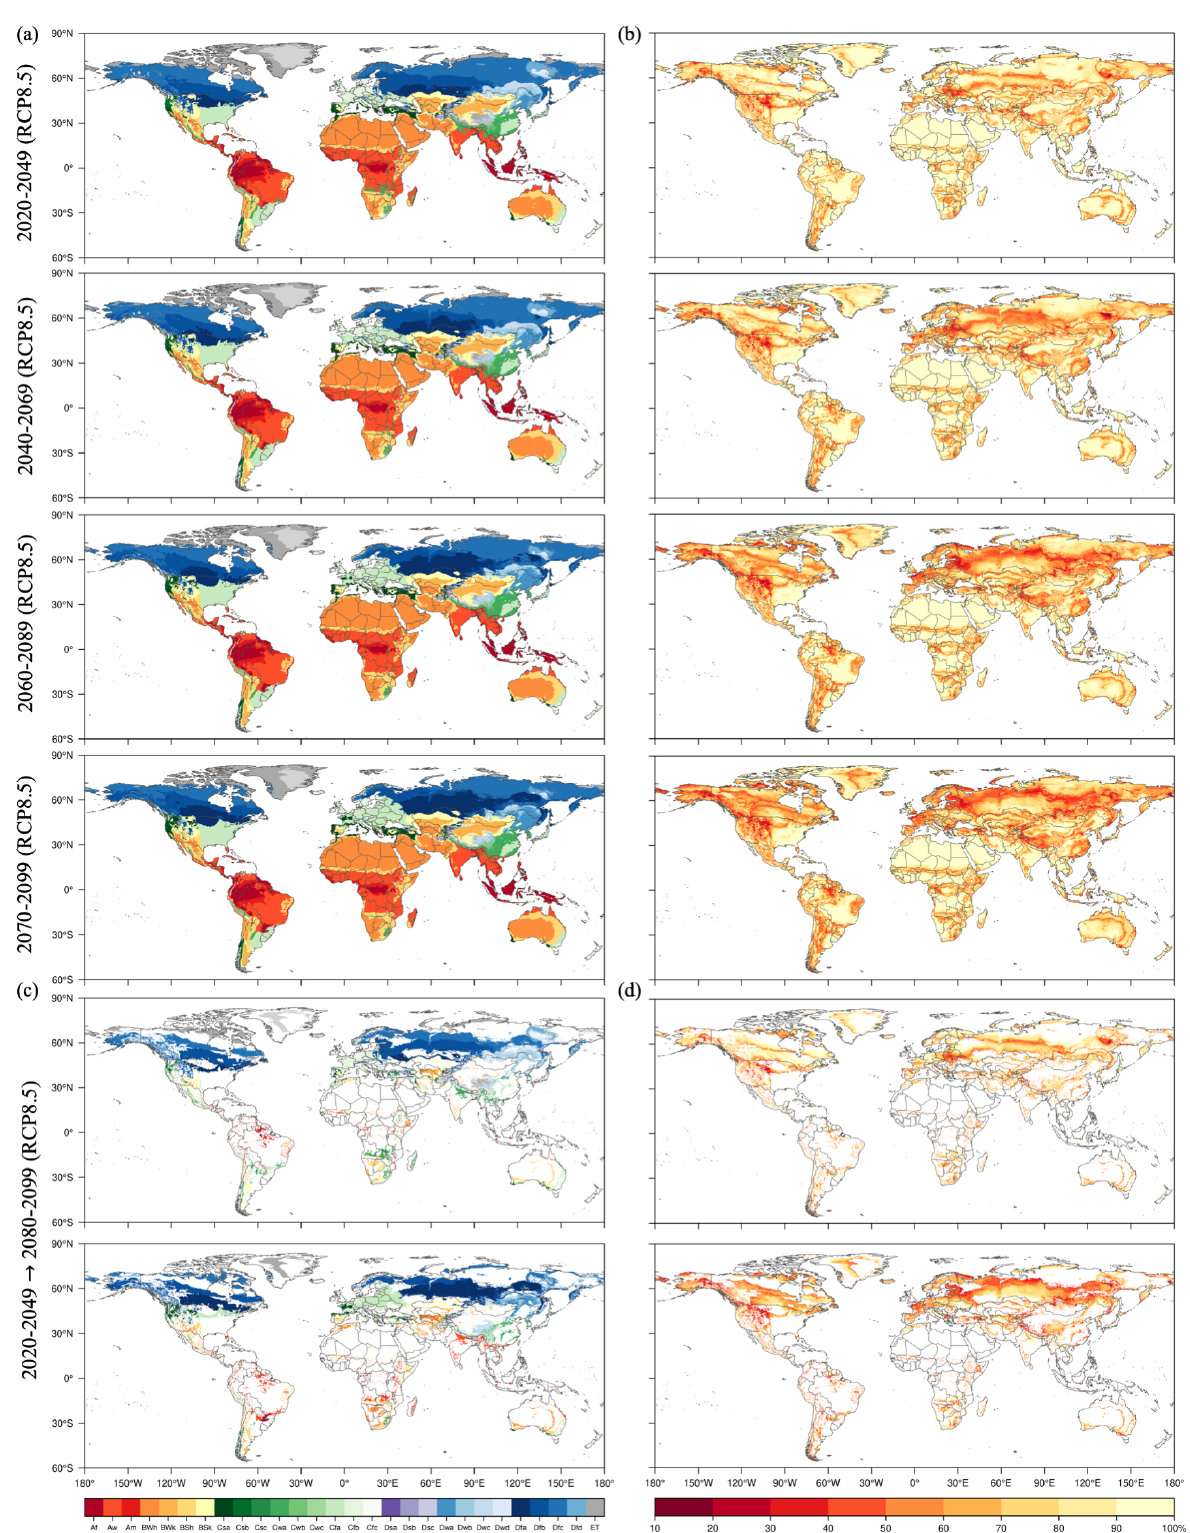
Figure 11. Global maps of the Köppen–Geiger climate classification for the future periods (2020–2049, 2040–2069, 2060–2089, 2070–2099) under RCP8.5 and associated classification confidence levels. (a) Future maps of the Köppen–Geiger climate classification and (b) confidence levels associated with the Köppen–Geiger climate classification. (c) Future changes in Köppen–Geiger climates from 2020–2049 to 2080– 2099 and (d) the associated confidence